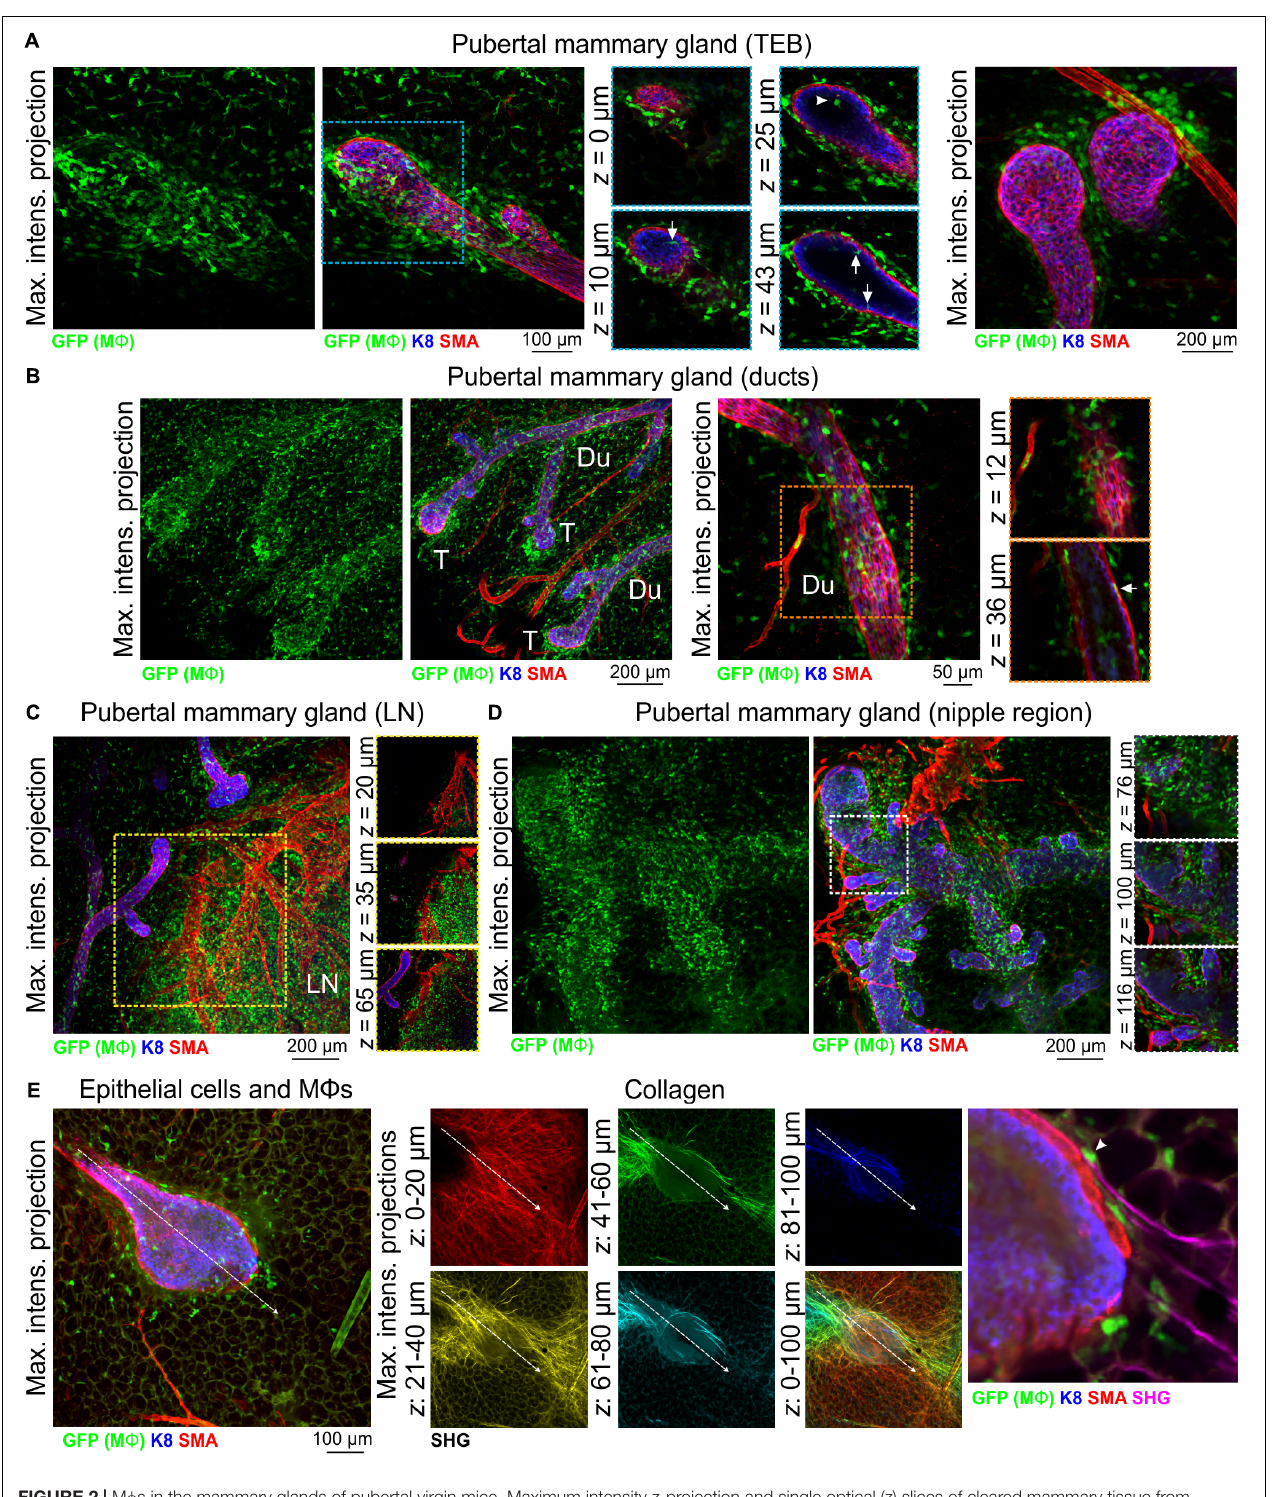
FIGURE 2 | M φ s in the mammary glands of pubertal virgin mice. Maximum intensity z -projection and single optical ( z ) slices of cleared mammary tissue from pubertal (6–7 week old) Csf1r-EGFP mice. K8 immunostaining reveals the luminal cell layer; SMA marks the basal cell layer and SMA-positive vessels. (A) terminal end buds (TEBs), (B) ductal regions, (C) inguinal lymph node, and (D) nipple region. Arrows in (A) show M φ s that have invaded the TEB epithelium and lumen (arrowhead). Arrow in (B) shows a M φ positioned between the epithelial bilayer. T, ductal tips; Du, ducts; LN, lymph node. Images are representative of 3 mice. (E) Second harmonic generation (SHG) showing fibrillar collagens around a TEB structure. Image stacks in middle panel are depth-coded (R-Y-G-C-B). Dashed arrow shows direction of TEB growth. Arrowhead in (E) shows a M φ interacting with collagen.